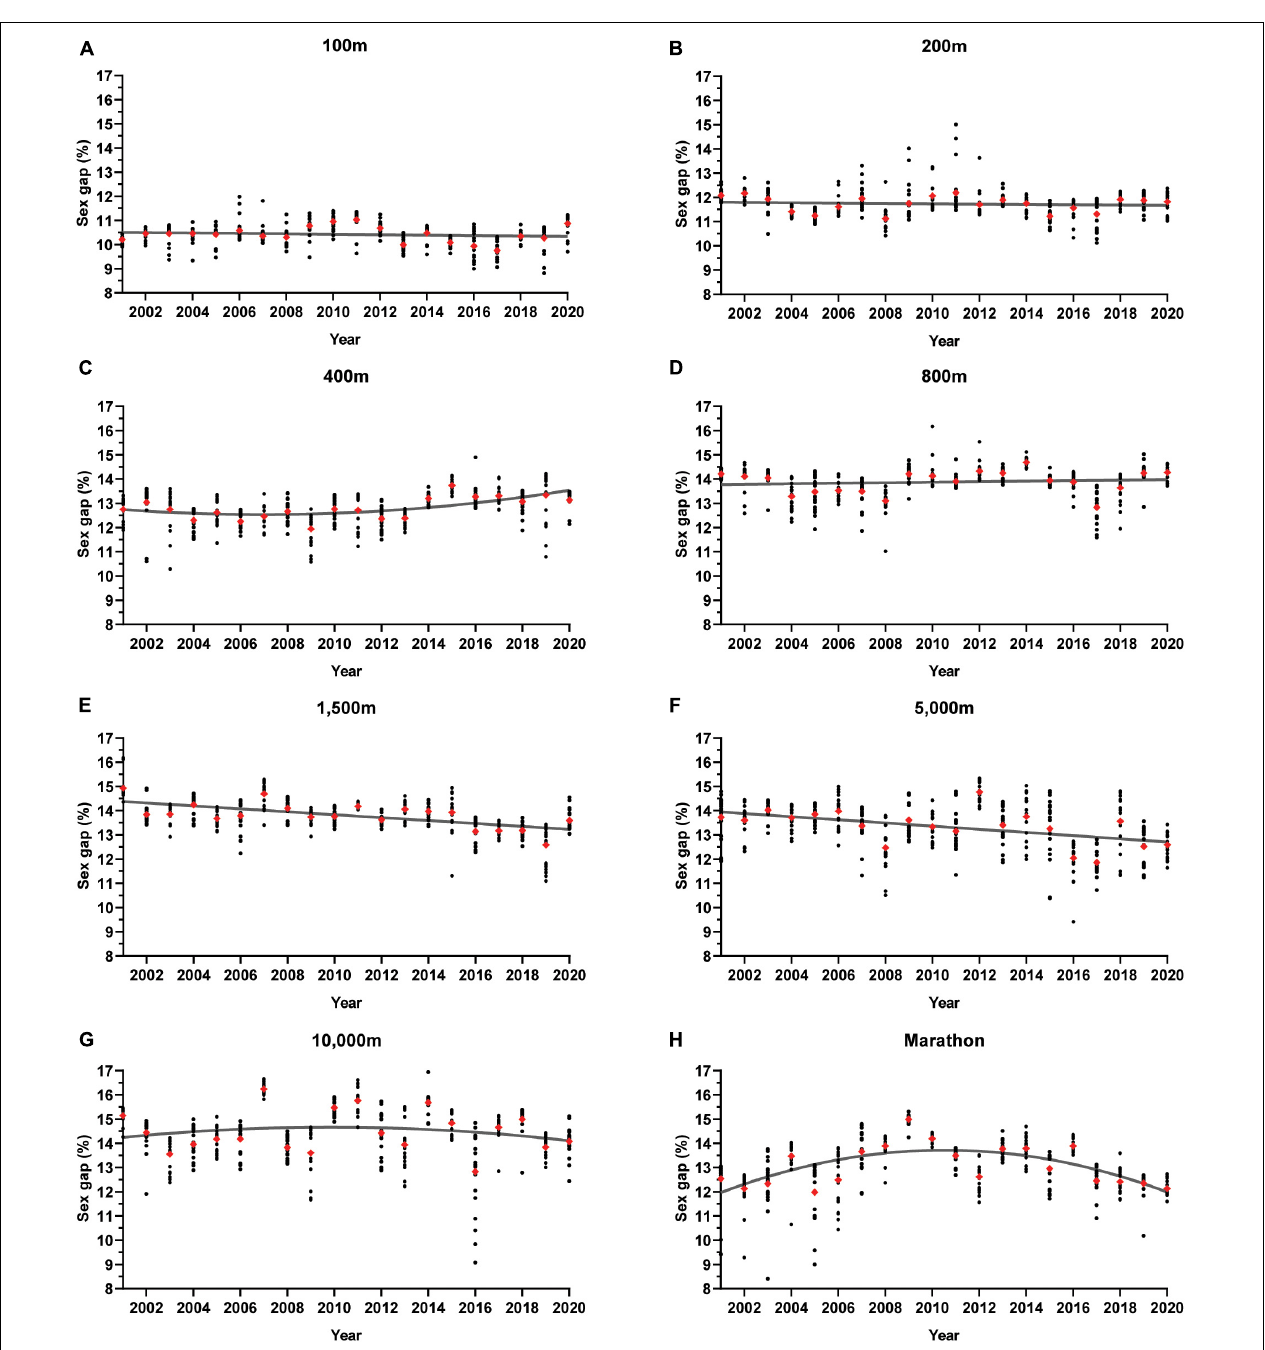
FIGURE 1 | The Sex Gap Over Time in Running Events 100 m to Marathon between 2001 and 2020. The sex gap % is calculated as the percent difference between male and female running times. The pairwise sex gaps for each top 20 ranked individuals (annually, worldwide) are plotted as black circles and the average top 20 sex gap for each year is plotted as a red diamond. Regression lines are fitted as the line of best fit. (A) 100 m, (B) 200 m, (C) 400 m, (D) 800 m, (E) 1,500 m, (F) 5,000 m, and (G) Marathon.